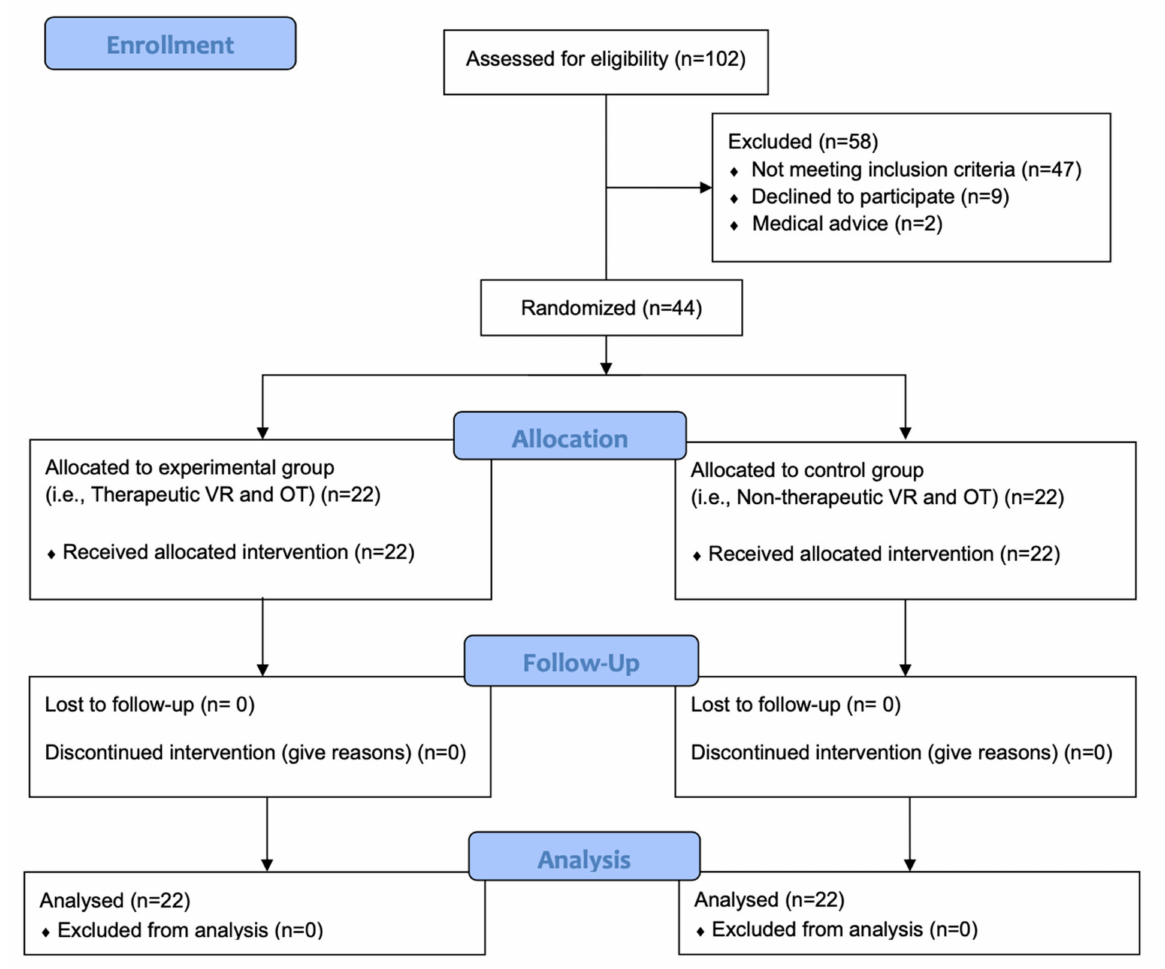
Figure 2. Consort Flow chart of the